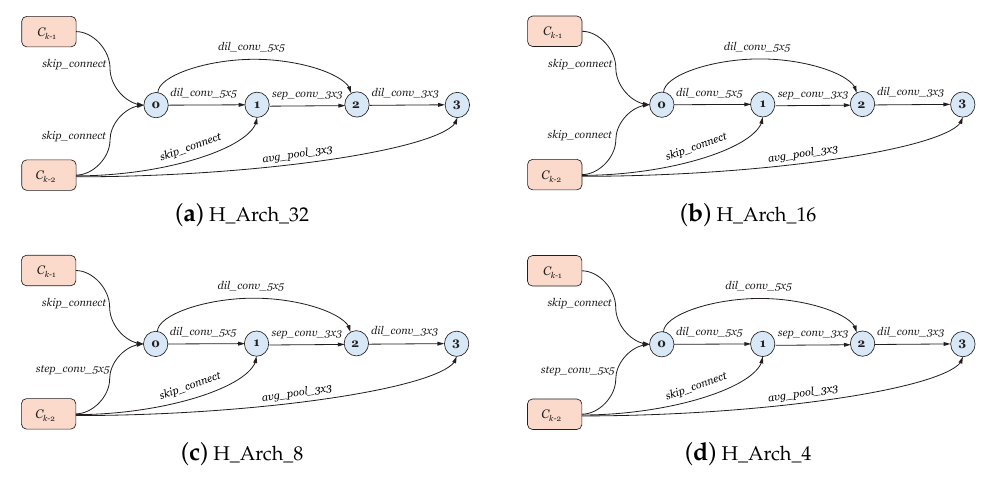
Figure A3. Cell structures obtained over HRSID with ops _ ratio = 0.